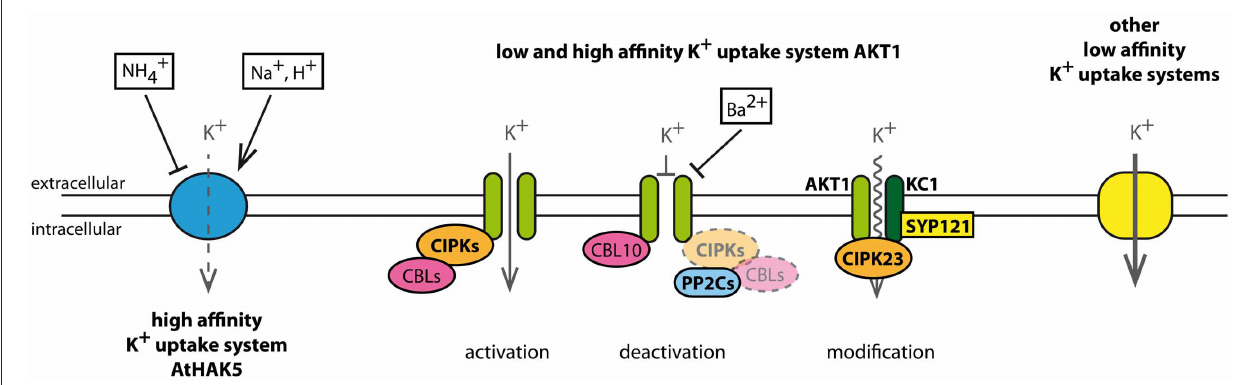
FIGURE 2 | K + uptake into Arabidopsis roots and its regulation. Depending on the actual K + concentration in the soil different low or high affinity K + uptake systems are active. At K + concentrations below 0.01mM only the high affinity transporter AtHAK5 is active. It is blocked by extracellular NH + 4 and stimulated by extracellular Na + and H + . The Shaker -like K + channel AKT1 is involved in high and low affinity K + uptake. It is a target of an extensive regulatory network that includes calcium sensors (CBLs), kinases (CIPKs), phosphatases (PP2Cs), and the ability to form heterotetramers with AtKC1. In the presence of CBL1 or CBL9, CIPK23 phosphorylates and activates AKT1. The interaction of CIPK 6, 16, and 23 each with CBL1, 2, 3, and 9 and its effect on